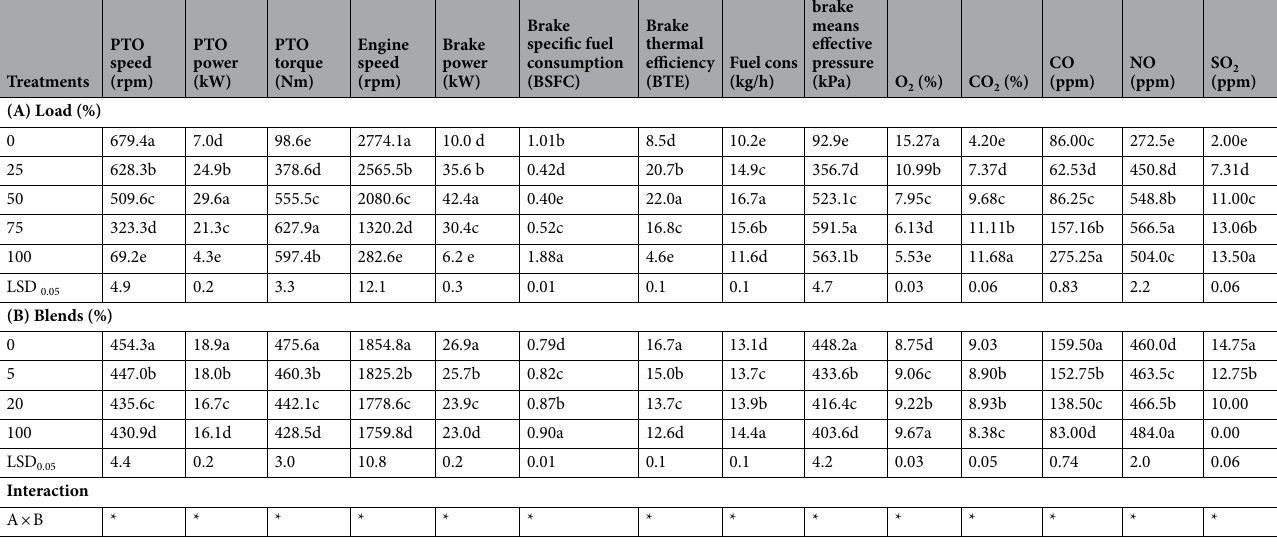
Table 1. Effects of engine load percentage and fuel blends percentage on power take-off speed, power take- off power, power take-off torque, engine speed, brake power, brake specific fuel consumption, brake thermal efficiency, fuel consumption, brake mean effective pressure, O 2 percentage, CO 2 percentage, CO, NO, and SO 2 . Means in column (s) followed by the same letter are not significant at the 0.05 level of probability. *Significant difference at the 0.05 level of